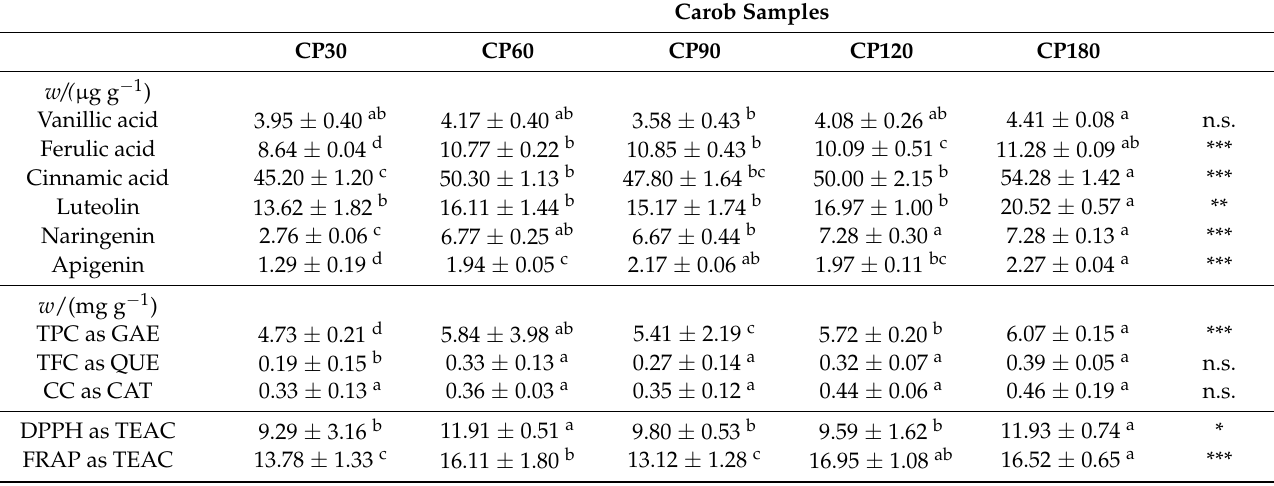
Table 2. Phenolic content and antioxidant properties of carob powder (CP) prepared by vibratory grinding at various processing